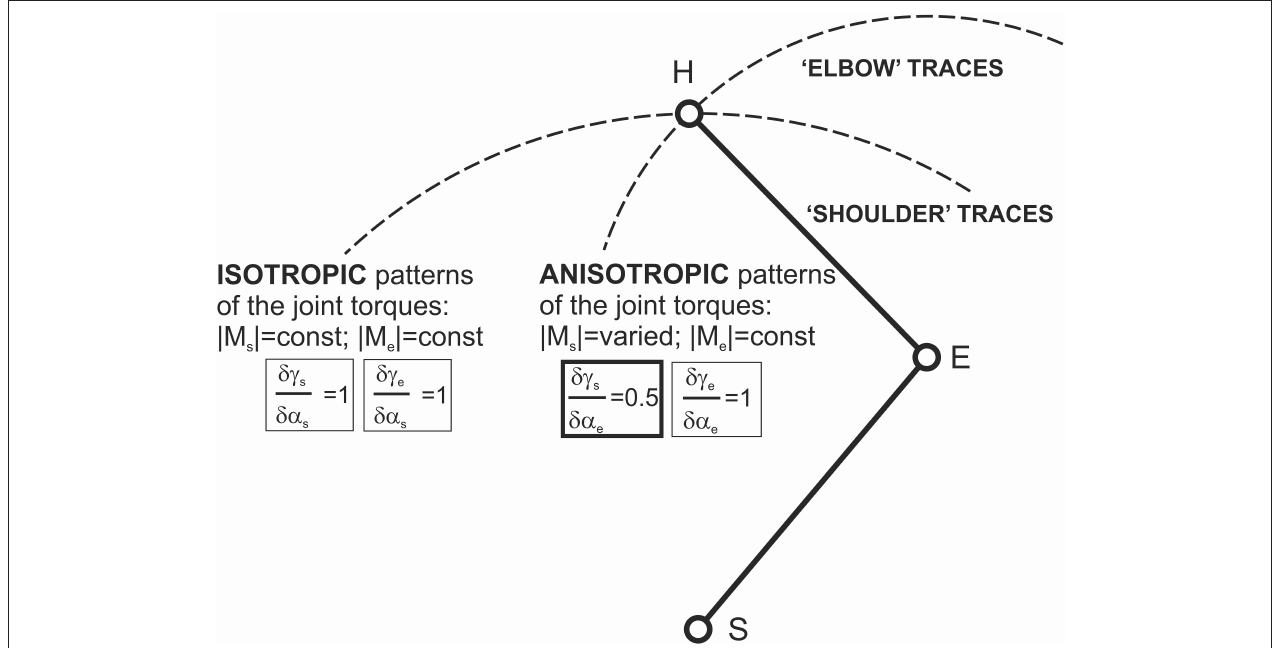
FIGURE 7 | Schematic description of possible differences given changes in the central commands to muscles during the end-point transitions along “shoulder” and “elbow” traces. These differences can be strongly connected with related patterns of the JT changes: isotropic in the first case and anisotropic in the second. Isotropy and anisotropy in changes to the JTs along the “shoulder” and “elbow” traces could be directly related to the equality (inequality) of the relative changes to the CAs γ s and γ e with respect to the correspondent joint